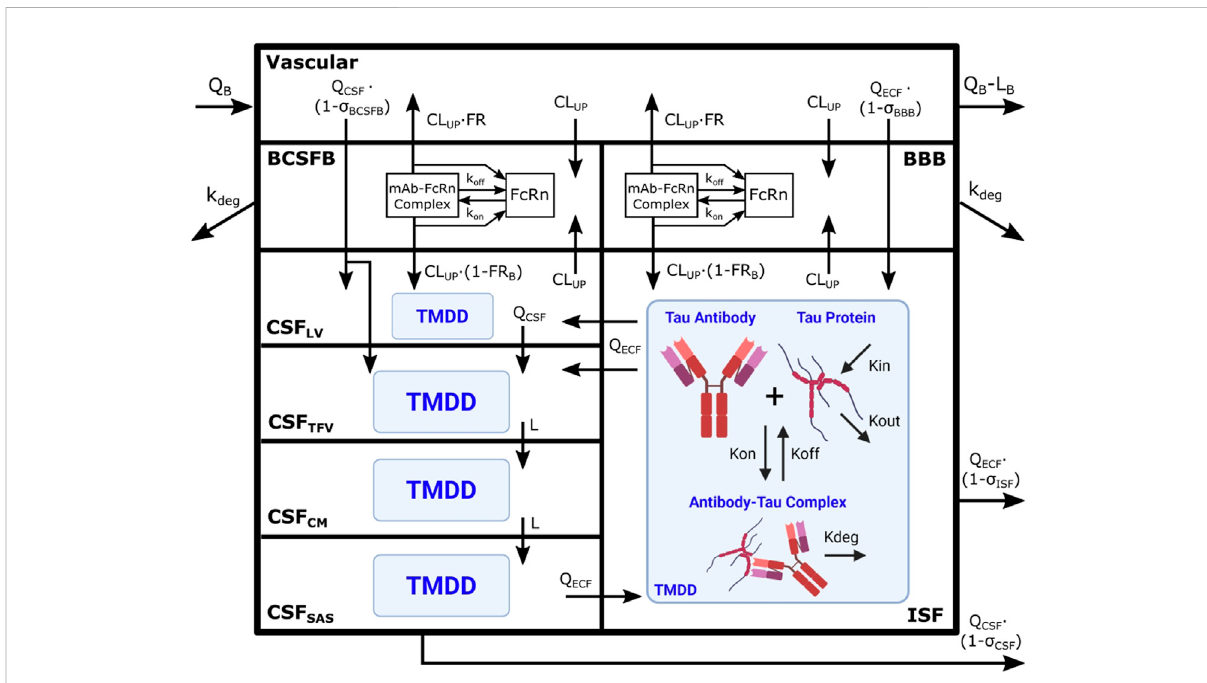
FIGURE 1 BrainPBPKmodelexpandedtoincludetaudynamics.Tauantibodyinteractionswithtauprotein,ortarget-mediateddrugdisposition(TMDD),is incorporated in brain ISF and four CSF compartments. The model contains 111 differential equations and 15 tissues, but we are only depicting the braincomponentsofthemodelforsimplicity.Antibodyentersthebrainvasculaturespacefromtheplasmacompartmentatthebrainblood fl owrate (Q B ) and leaves at a fl ow rate of (Q B – L B ). Antibody enters the brain ISF and CSF through paracellular transport across brain barriers, BBB and BCSFB. Paracellular transport across the BBB and BCSFB is governed by brain extracellular fl uid (Q ECF ) and CSF (Q CSF ) fl ow and brain vasculature re fl ection coef fi cients ( σ BBB and σ BCSFB ). Antibody also enters the brain transcellularly, which is driven by non-speci fi c pinocytosis represented in the model as an uptake clearance (CL UP ). Antibody in the endosomal space is able to bind FcRn, form an antibody-FcRn complex, and recycle to